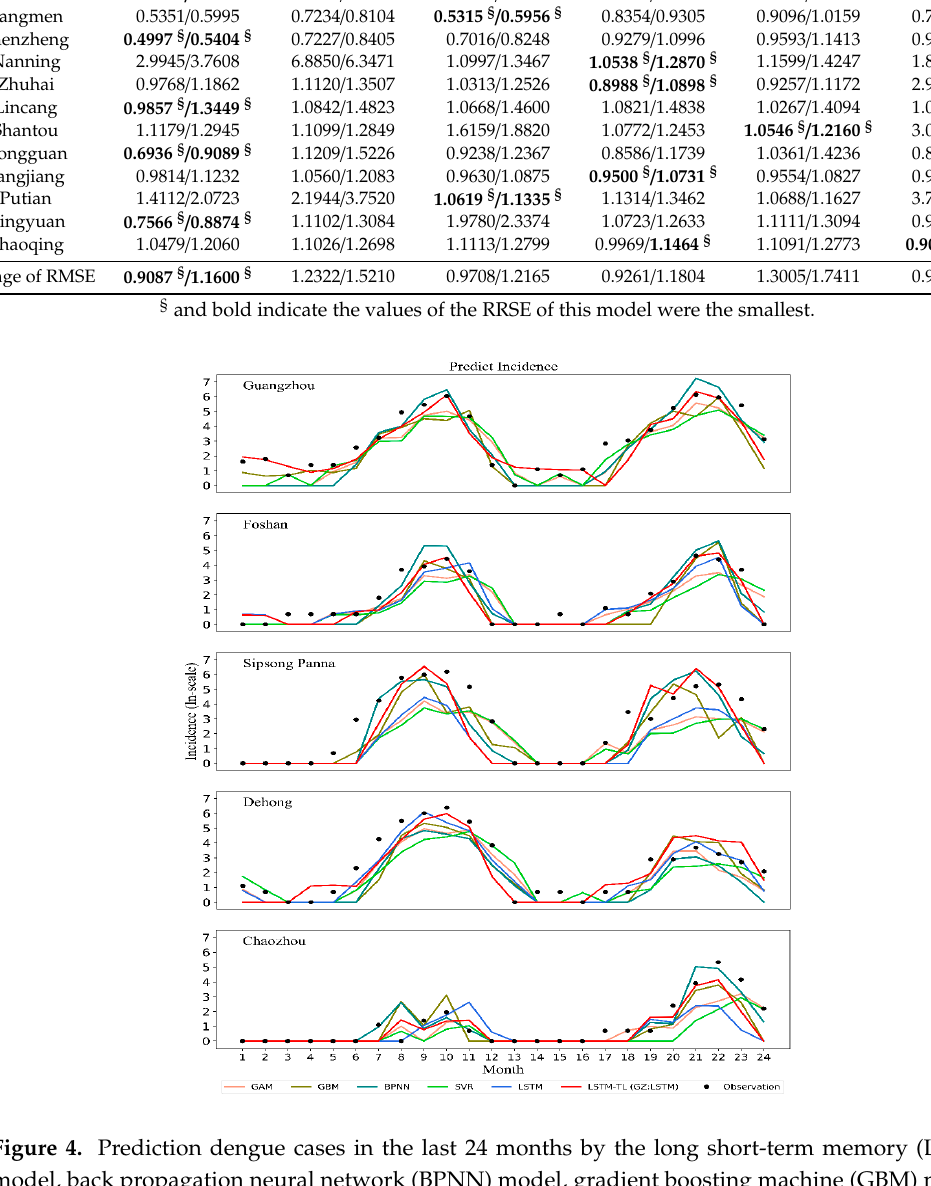
Figure 4. Prediction dengue cases in the last 24 months by the long short-term memory (LSTM) model, back propagation neural network (BPNN) model, gradient boosting machine (GBM) model, generalized additive (GAM) model, and support vector regression (SVR) model. Comparison of 24-month predictions for 2017 to 2018 in Guangzhou, Foshan, Sipsong Panna, Dehong, and Chaozhou which pose a high degree of dengue infection.